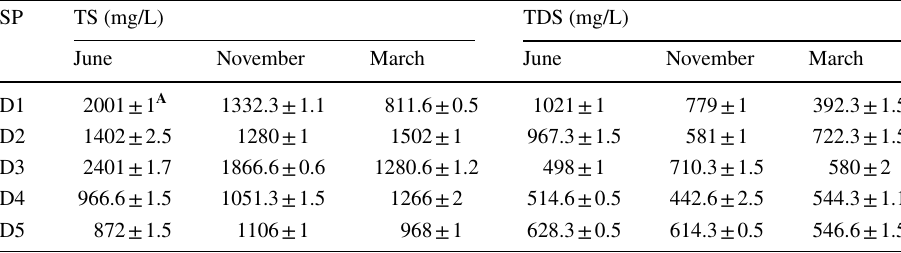
combined drains of HIE